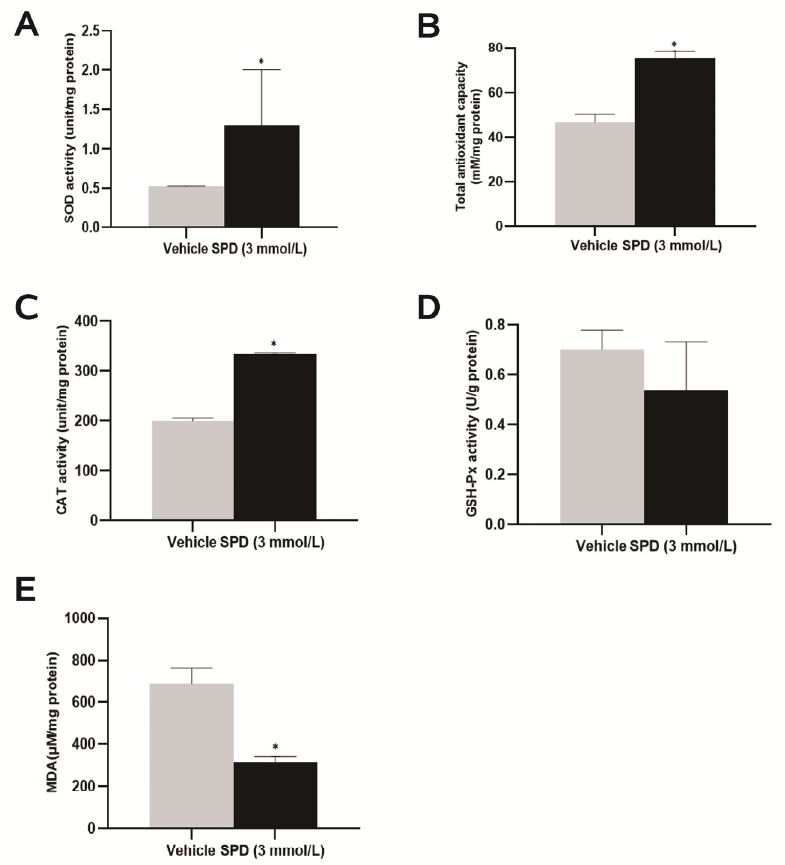
Figure 4. The effects of spermidine on total antioxidant capacity, antioxidant enzymes and lipid peroxidation in mouse ovaries. ( A ) SOD enzyme activity detection. ( B ) Total antioxidant capacity test. ( C ) CAT viability detection. ( D ) GSH-px viability detection. ( E ) MDA level detection. The results shown are representative of three independent experiments. * p < 0.05 vs. control.